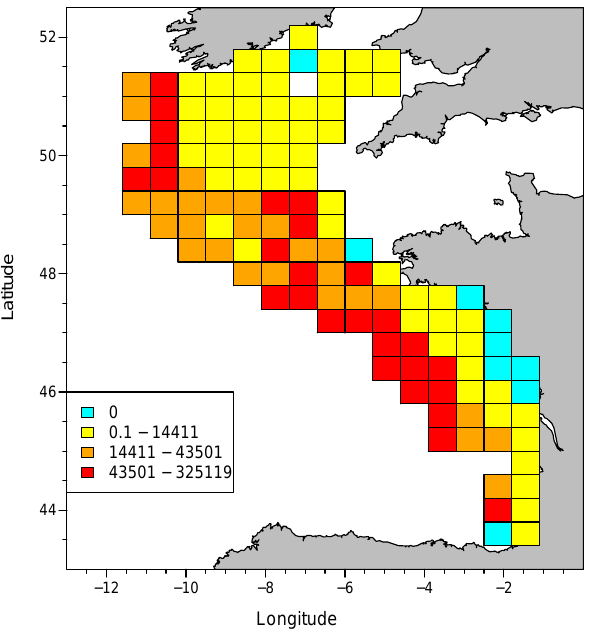
Figure 9. Average density (numbers per km 2 ) of blue whiting dur- ing autumn in the period 1997–2011 in the EVHOE survey.